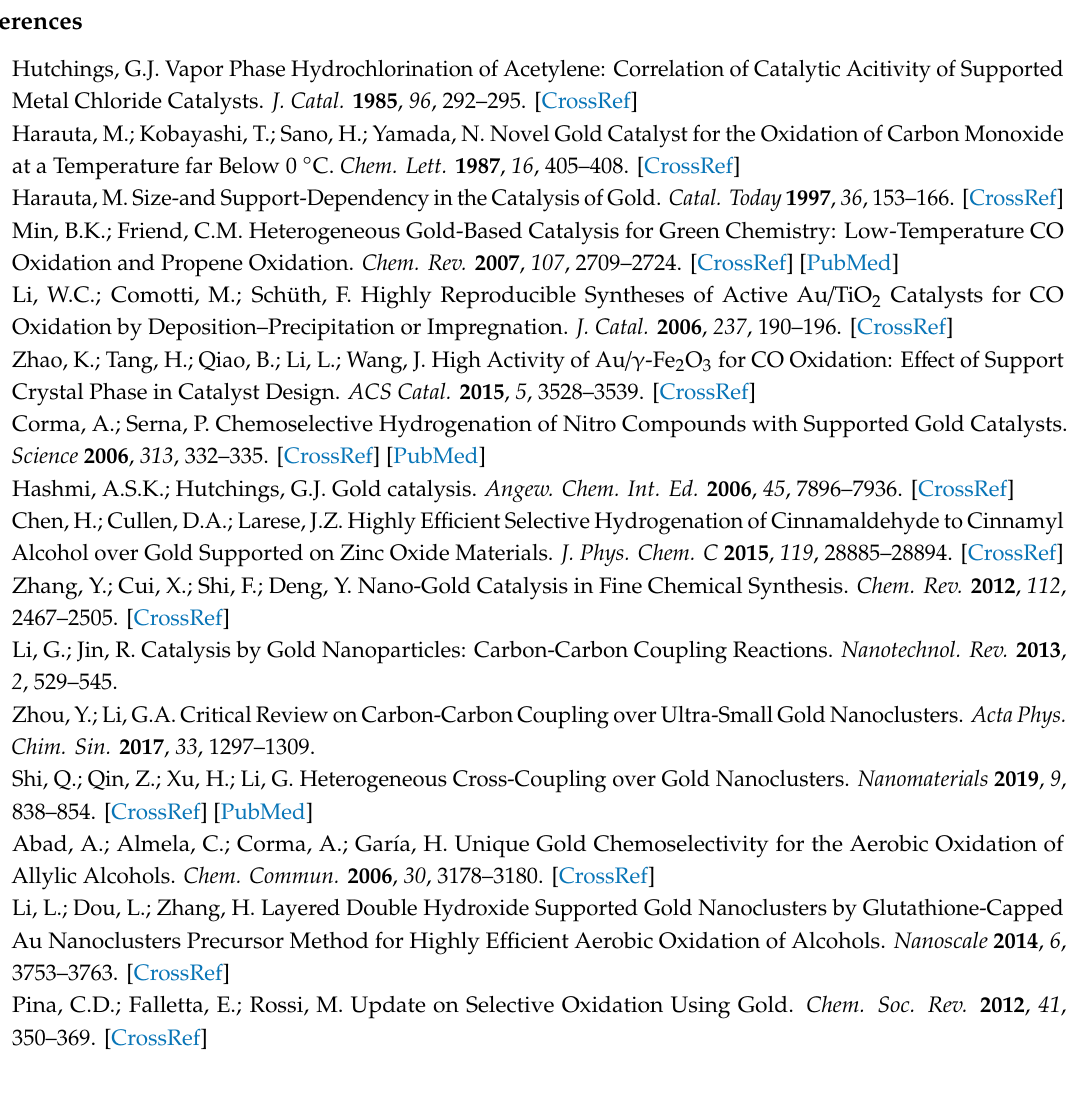
Figure S1: N 2 adsorption / desorption isotherms and pore size distributions of di ff erent supports, Figure S2: XRD patterns of di ff erent supports, Figure S3: HRTEM images of di ff erent supported gold catalysts, Figure S4: XPS spectra of O 1s on di ff erent supported gold catalysts, Figure S5: TEM image and size distribution histogram of 1.1% Au 25 / MgAl-300 catalyst, Figure S6: TEM images and size distribution histograms of gold catalysts with di ff erent preparation methods, Figure S7: The reusability of Au 25 / MgAl-300 catalyst in benzyl alcohol oxidation, Figure S8: The TEM images and size distributions of Au 25 / MgAl-300 catalyst after reusing three times, Table S1: Physicochemical properties of di ff erent supports, Table S2: The adsorption quantities of CO 2 , NH 3 and O 2 over di ff erent supported gold